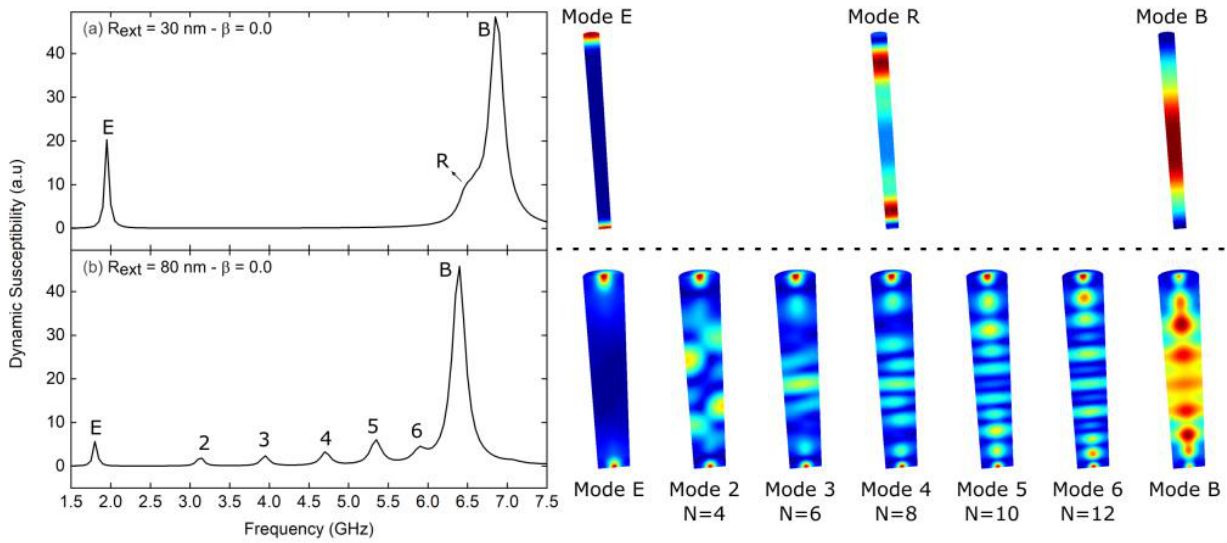
Figure 4. Dynamic susceptibility spectra for 1000 nm long Fe 3 O 4 nanotubes with external radius ( a ) R ext = 30 nm and ( b ) R ext = 80 nm, for = 0.0, while the system is excited with a sinc wave field in the y -direction. On the right are the spatial profiles of the resonant modes shown to the left. The color scale corresponds to the amplitude of the magnetic moment fluctuations, with red depicting the largest amplitude and blue denoting zero amplitude.